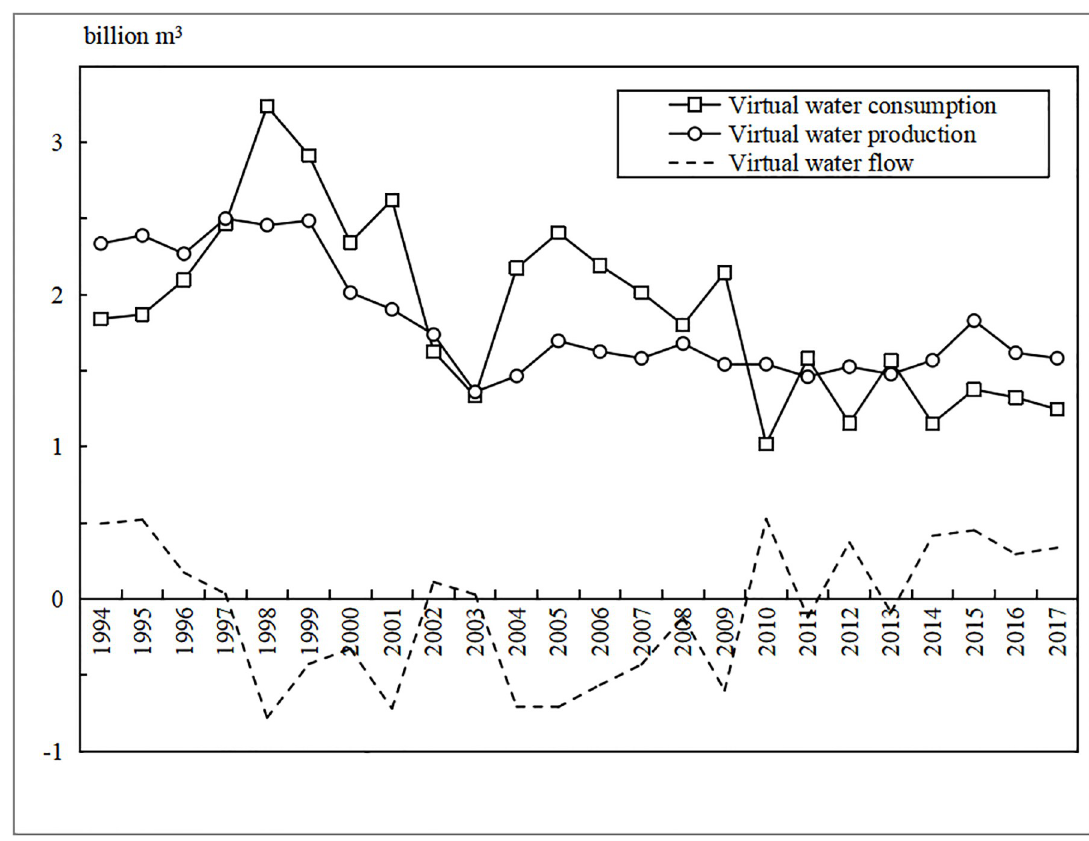
Fig 10. Agricultural virtual flows during 1994–2017.